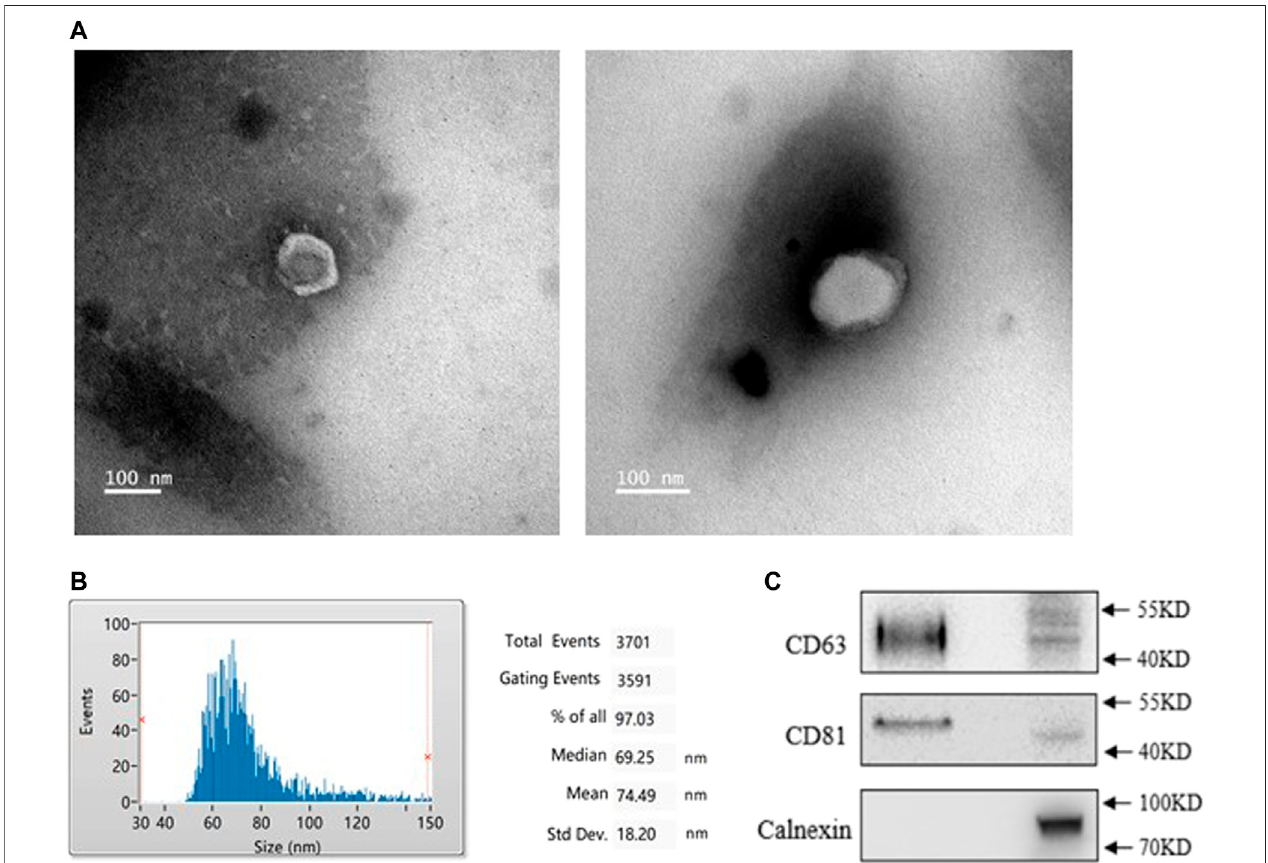
FIGURE 1 | Identi fi cation of exosomes from healthy (NC) and PMOP patients (PP). (A) Morphology of exosomes was scanned by Transmission electron microscopy (TEM), scale bar = 100 nm. (B) The diameter distribution of exosomes. (C) Protein expressions of exosomal markersCD63, CD81, and Calnexin. All results are presented with three